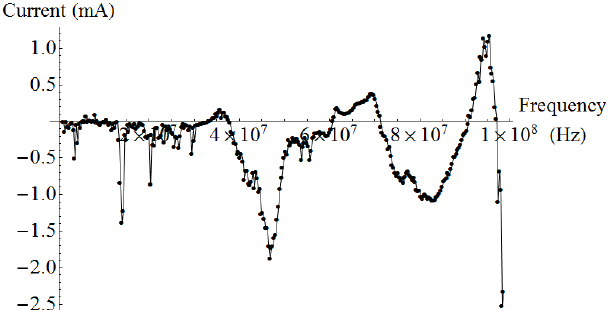
Figure 10: Effects induced by connected appliances ( factor 2 ) in the low voltage network on the mean end-current ) magnitude ( a 2, µ